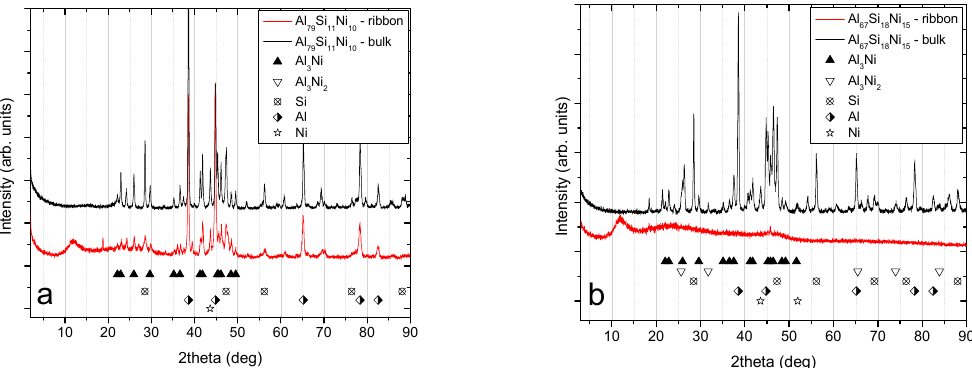
Figure 4. X-ray diffraction patterns for the bulk and melt-spun alloys: ( a ) Patterns for the Al 79 Si 11 Ni 10 bulk and melt-spun ribbons; ( b ) patterns for the Al 67 Si 18 Ni 15 bulk and melt-spun ribbons. The variation of the crystallite size as function of cooling rate for the Al 79 Si 11 Ni 10 for the bulk alloy and melt-spun ribbons can be seen in Figure 5. The crystallite size for the higher intensity diffraction peaks was calculated with the Scherrer equation [25]. The structural refinement is obvious, for all the phases that were analyzed, with as high as 55% reduction in size for the (311) direction for the melt-spun ribbon.